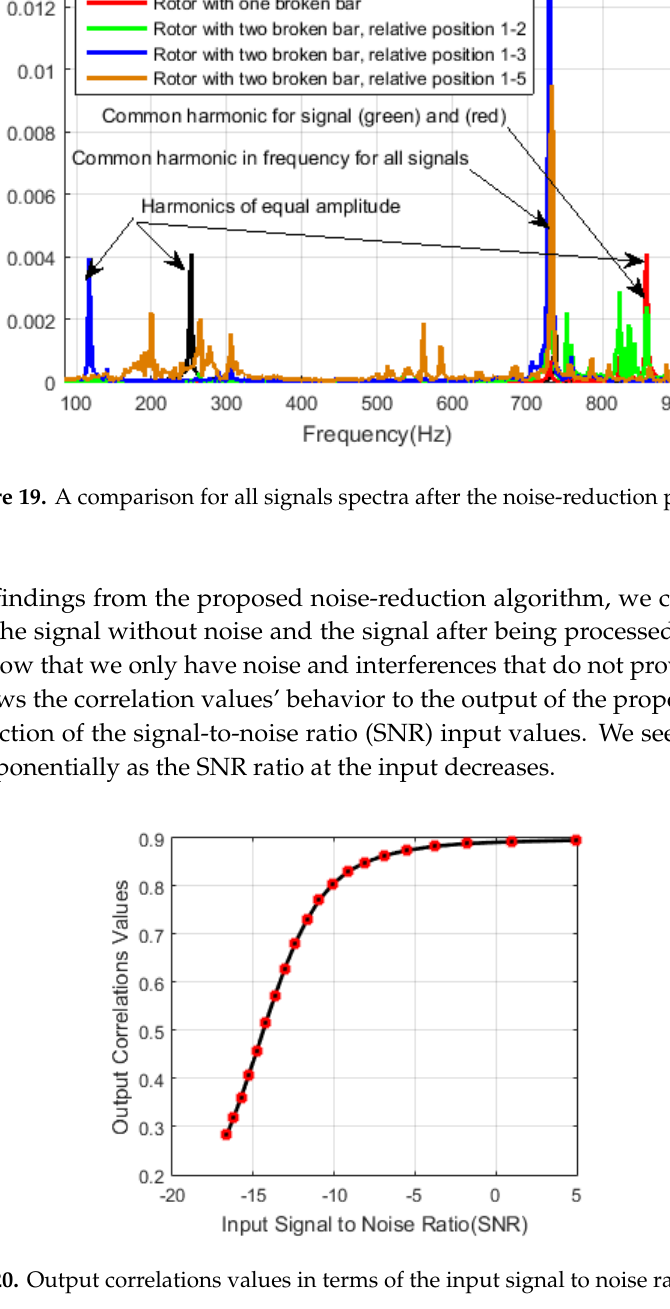
Figure 19. A comparison for all signals spectra after the noise-reduction process.